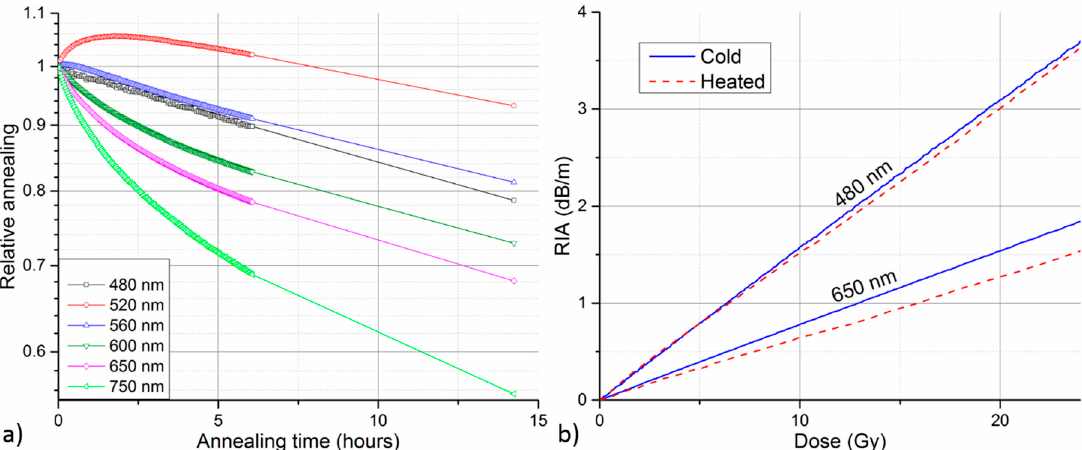
Figure 4. ( a ) Relative annealing of fiber’s RIA at selected wavelengths after irradiation at 150 Gy/h. ( b ) Comparison of fiber’s RIA growth at two selected wavelengths under room (cold, 20 ◦ C) and elevated (heated, 40–50 ◦ C) temperature. Irradiations were performed at a dose rate of 150